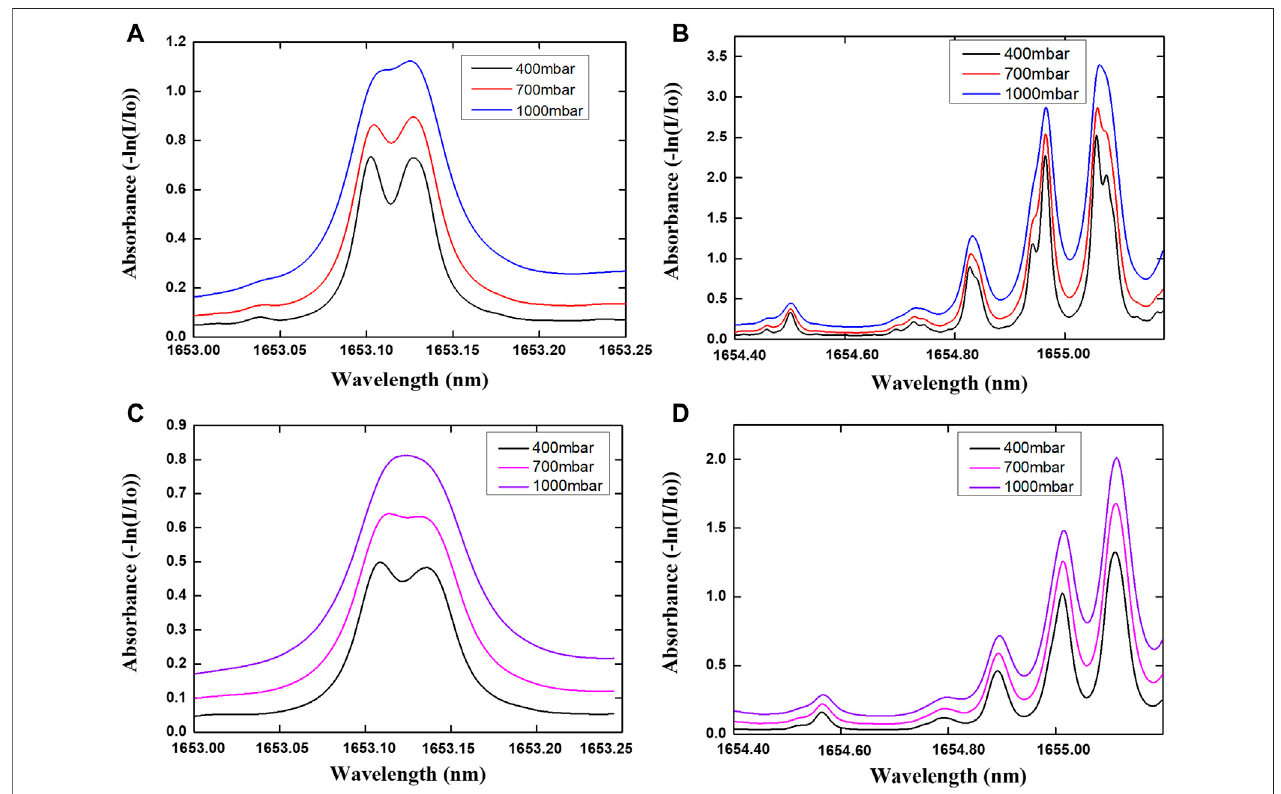
FIGURE 7 | The experimental and simulation absorbance curves of 10% CH 4 and 90% N 2 in each section at 400, 700, 1000 mbar pressures: (A) HITRAN2016 Simulated absorbance curve for 13 CH 4 and (B) for 12 CH 4 ; (C) Experimental absorbance curve for 13 CH 4 and (D) for 12 CH 4 .